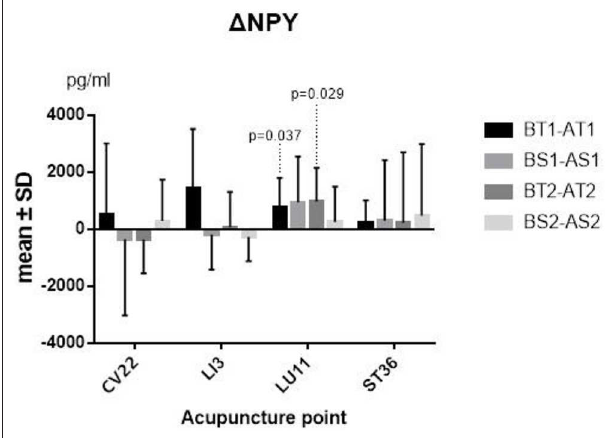
Frontiers in Medicine |